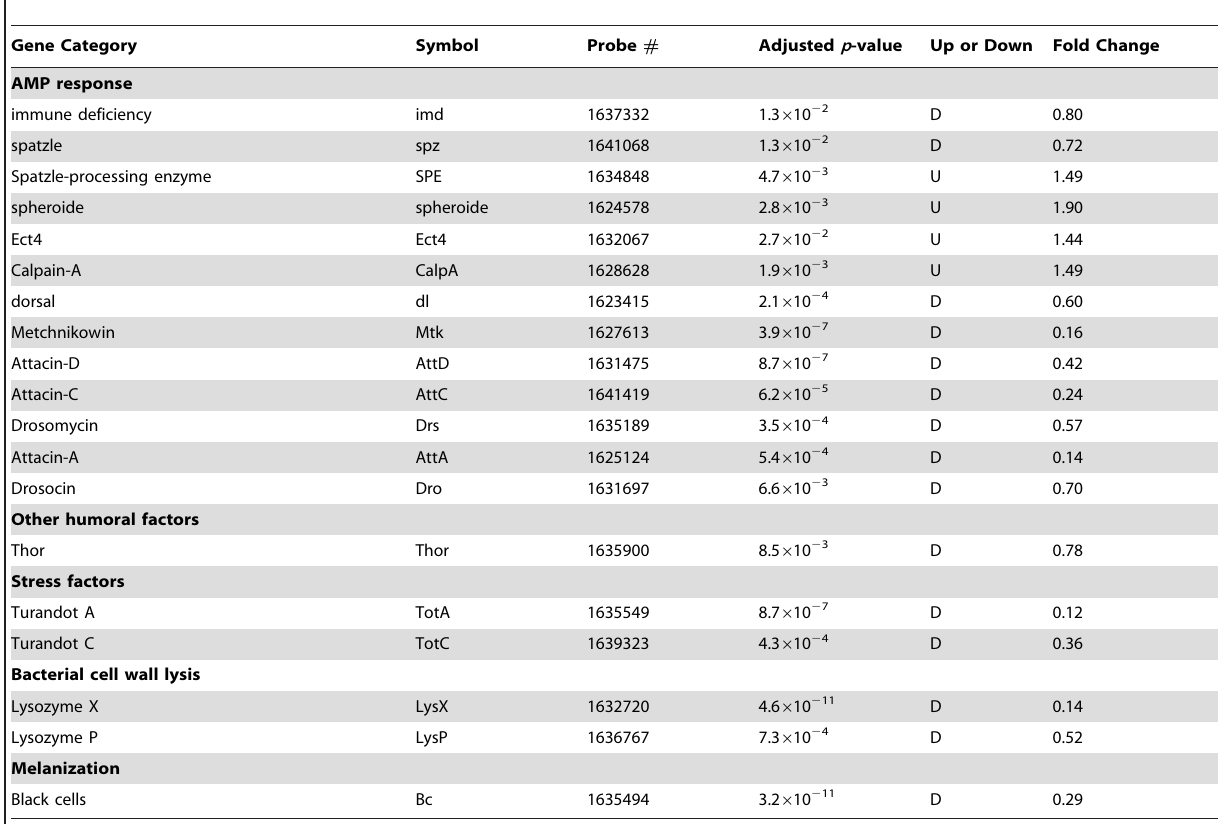
Table 2. The constitutive expression of humoral immunity genes is altered in spaceflight larvae.